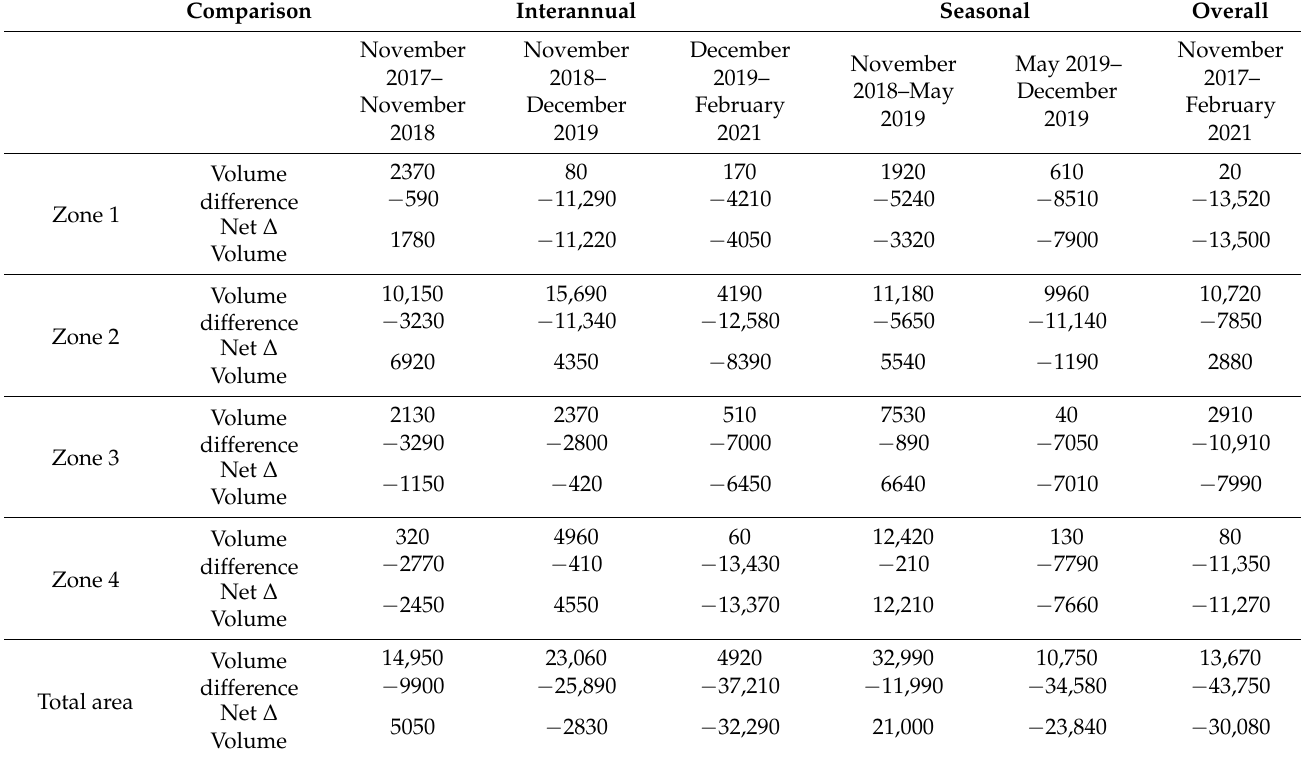
Table 2. Volumetric difference estimates among DTMs (in m 3